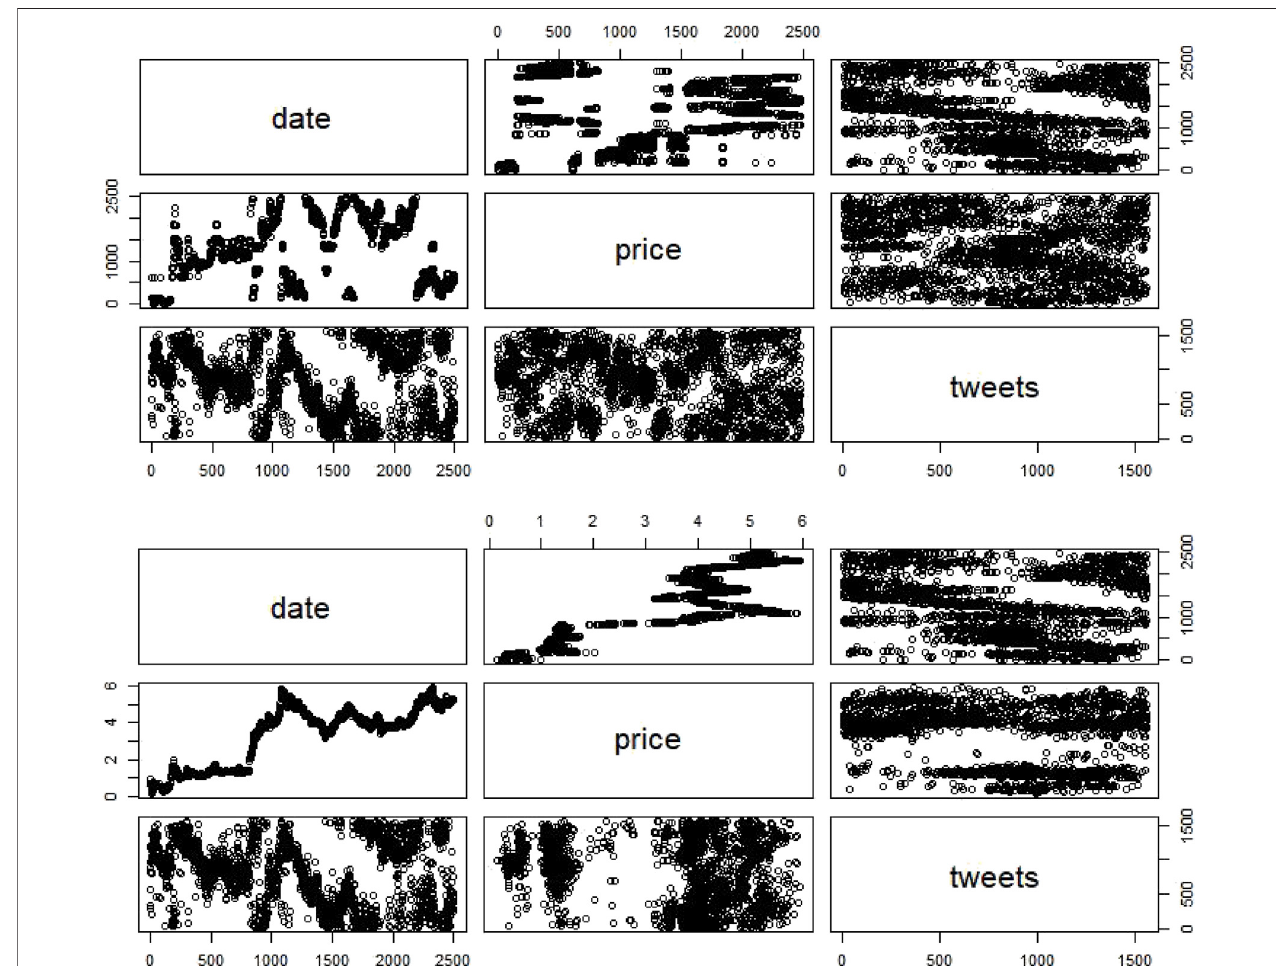
FIGURE 4 | Litecoin non-stationary and stationary